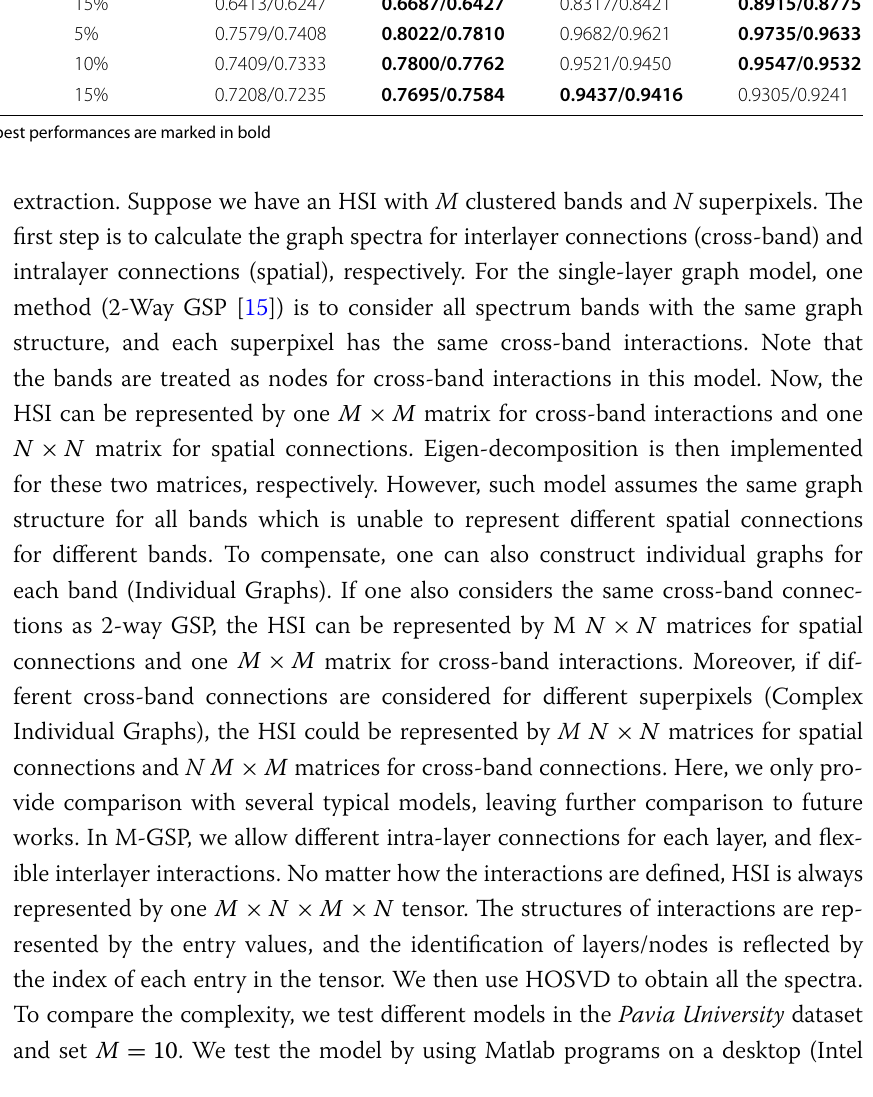
The best performances are marked in bold